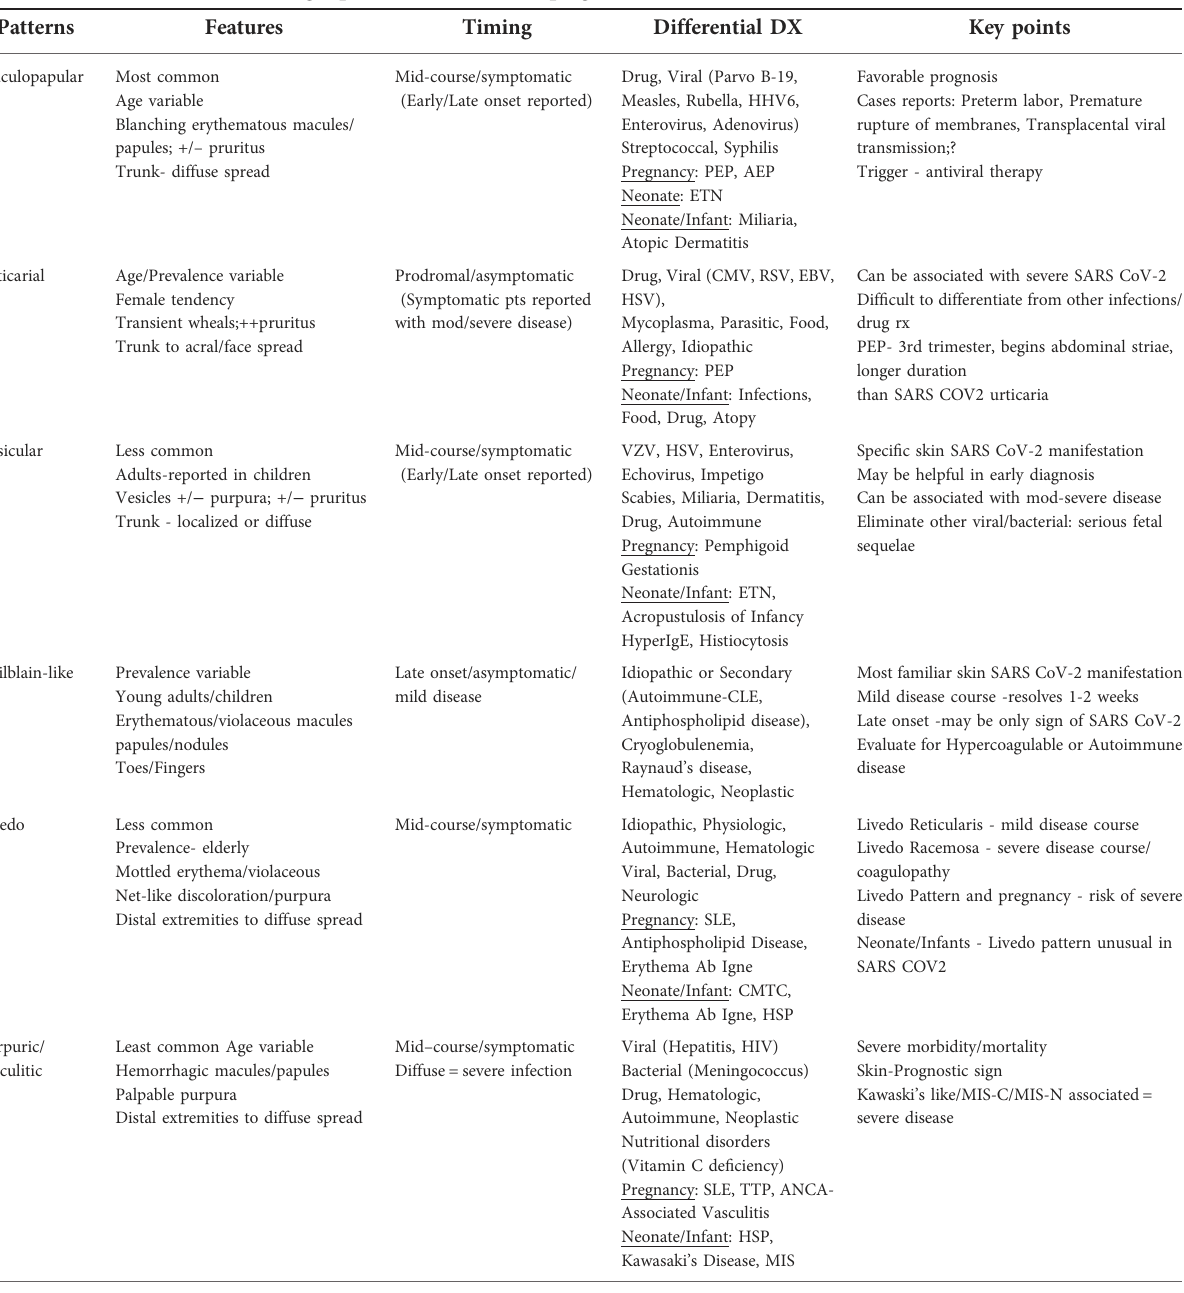
TABLE 1 Summarizes SARS CoV-2 associated dermatologic patterns and relevant clinical aspects in pregnant women, neonates, and infants. SARS CoV-2 associated dermatologic patterns: relevance in pregnant women, neonates and infants